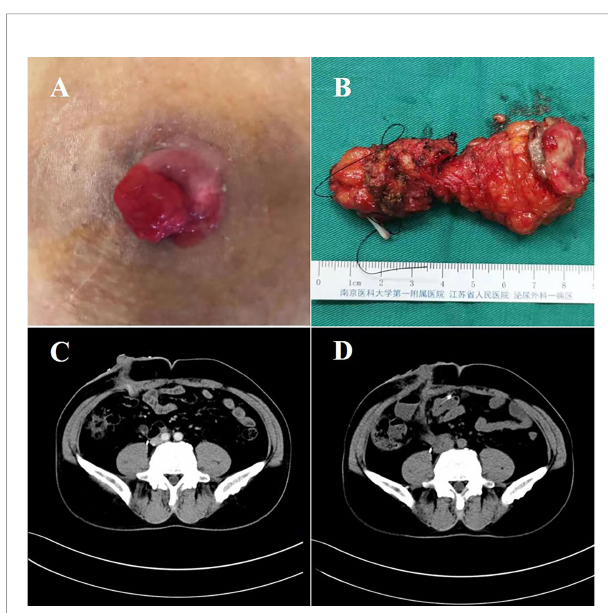
FIGURE 1 | Surgical specimens and CT images. (A) The stoma mass of the patient before surgery. (B) The resected ureter after surgery. (C) CT image of the patients ’ stoma mass before surgery. (D) CT image of the patients ’ abdominal organs after surgery. CT, computed